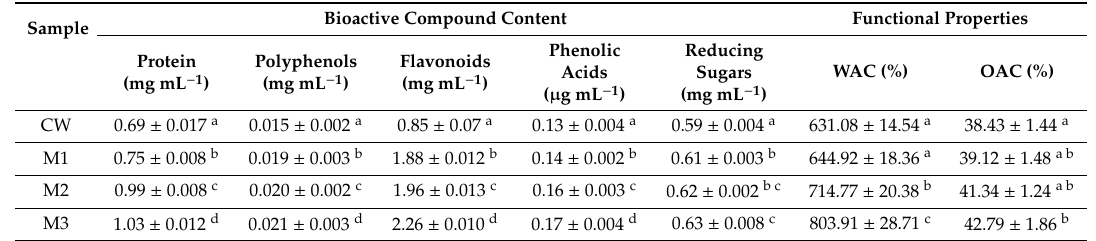
Table 2. Influence of millet flour on color characteristics and rheological properties of